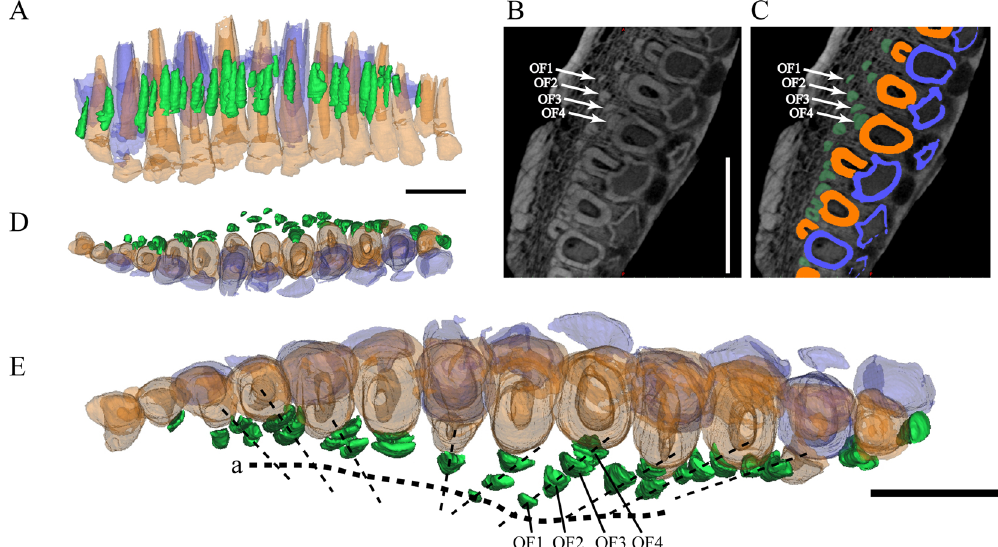
Figure 4. The remains of resorbed functional teeth in Liaoceratops yanzigouensis . Right maxilla of IVPP V12738. Elements in the CT reconstructions are colour-coded as follows: functional teeth, orange; replacement teeth, blue; old resorbed functional teeth, green. Transparent reconstructed and extracted right maxillary teeth composite in labial view ( A ), dorsal view ( D ) and ventral view ( E ). ( B , C ) longitudinal CT cross sections through the right maxilla. The dotted line ( E ) represent the possible growth track of the functional teeth and their predecessors. Scale bars equal 10 mm.